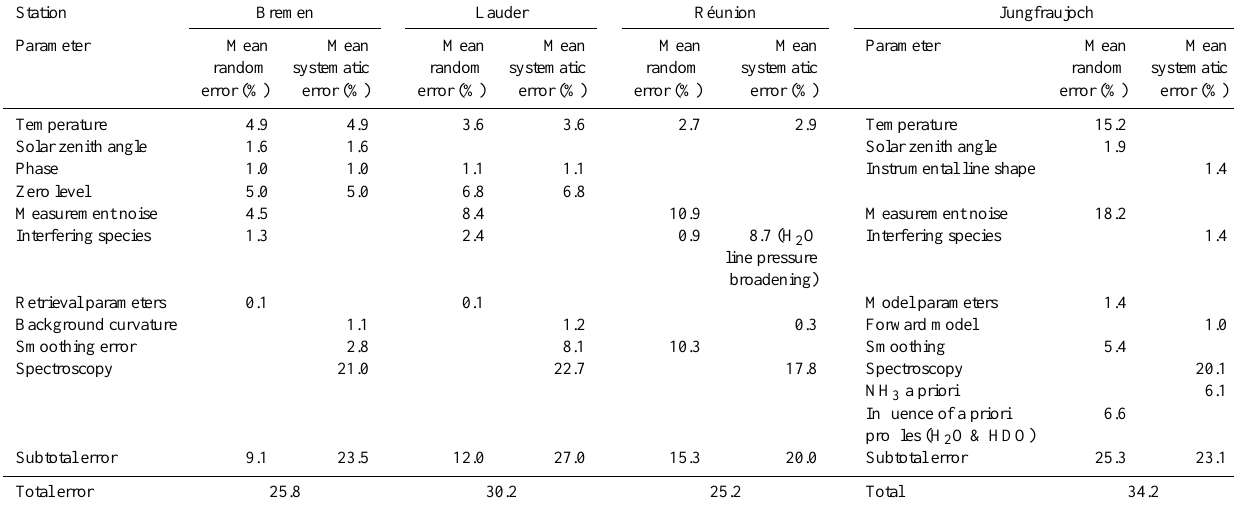
Table 4. Mean random and systematic errors for each of the individual NH 3 retrieval parameters. The table is split into two sections to cover both the error calculation using SFIT4 (Bremen, Lauder, Réunion) and SFIT2 (Jungfraujoch). At the bottom the errors are summarized into total mean errors for each of the